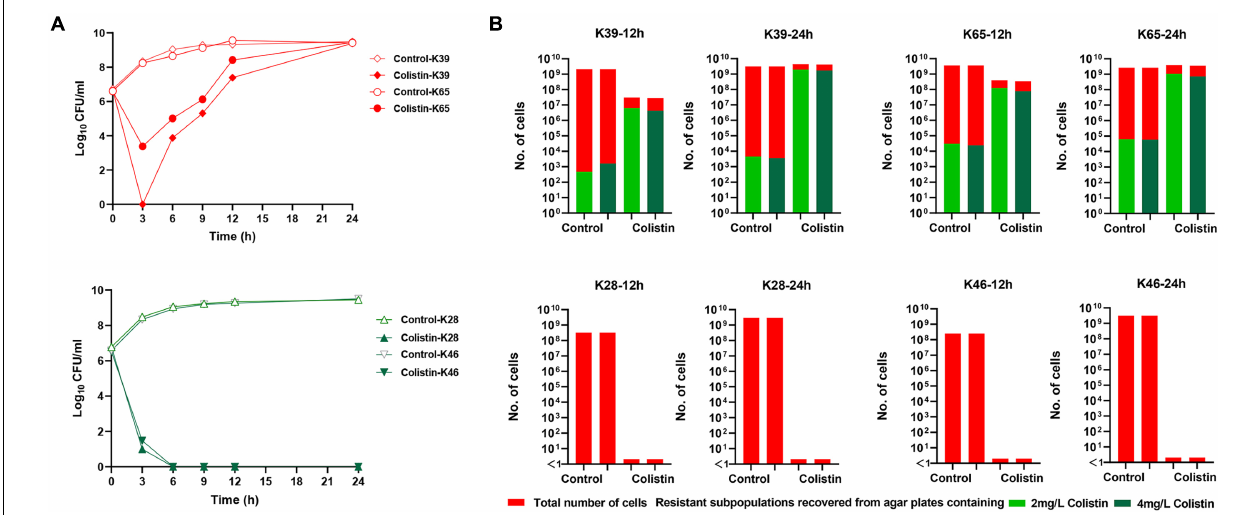
FIGURE 3 | Time-kill curves of colistin monotherapy with 1 × MIC against carbapenem-resistant Klebsiella pneumoniae (CR-KP) strains and proportion of resistant subpopulations during the time-kill assays. ( A ,i) Time-kill curves of colistin monotherapy against two representative strains with colistin heteroresistance (K39 and K65). ( A ,ii) Time-kill curves of colistin monotherapy against two representative strains without colistin heteroresistance (K28 and K46). (B) Number of resistant subpopulations at 12 and 24 h in the control group and colistin monotherapy groups during time-killing assays. Bacteria were plated on the agar plates containing 2 and 4 mg/L colistin, and the resistant subpopulation of CFUs was